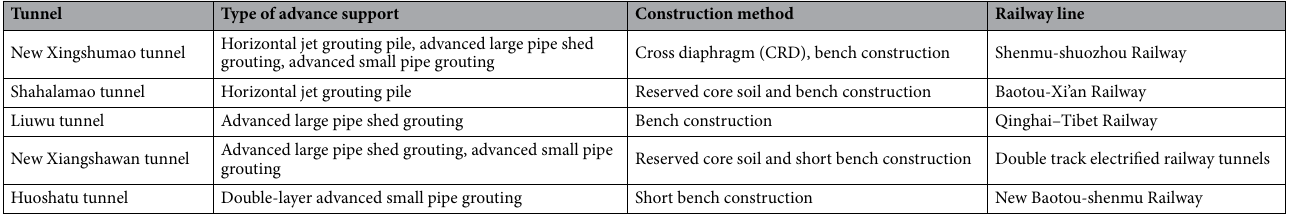
Table 6. Projects in aeolian sand formations in